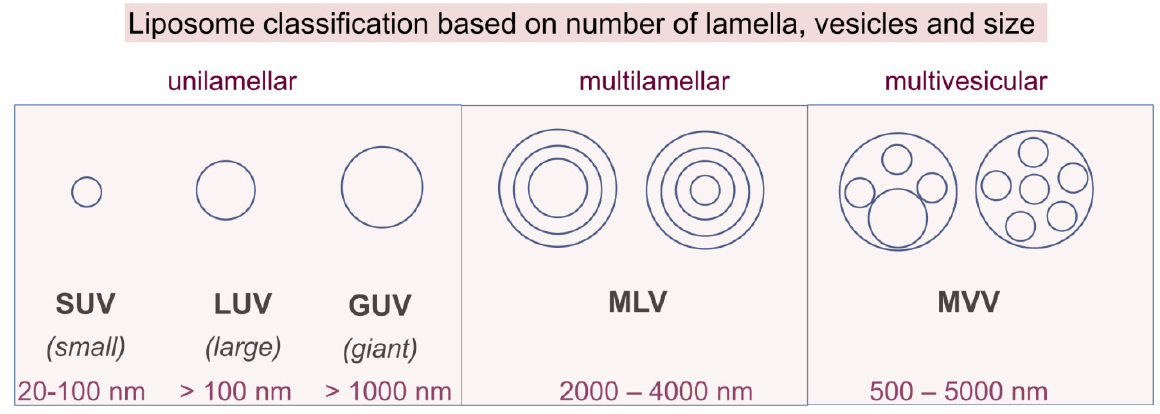
Figure 8. Types of liposomes based on structure and size.